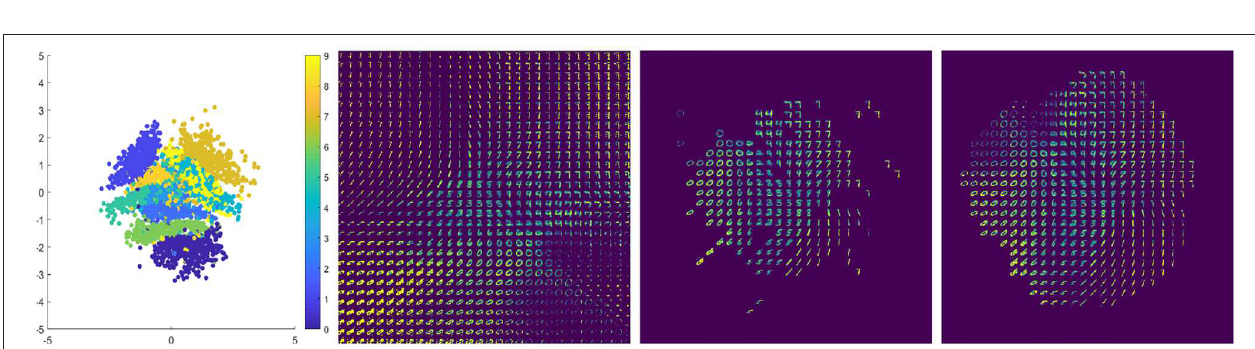
FIGURE 1 | (Top) Examples of the two data sets with varying ̺ , the difference between the principle axis lengths. (Middle) Points deemed significant by the Gaussian witness function for given ̺ . (Bottom) Points deemed significant by the Hermite witness function for given ̺ . In all figures, green corresponds to 0, meaning neither distribution dominates.